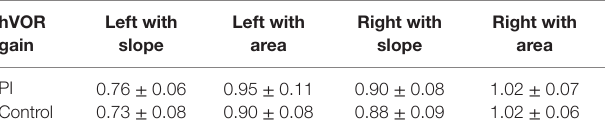
TaBle 2 | Mean hVOr gain calculated with slope and area methods in Pi and control seniors groups. hVOr left with left with right with right with gain slope area slope area PI 0.76 ± 0.06 0.95 ± 0.11 0.90 ± 0.08 1.02 ± 0.07 Control 0.73 ± 0.08 0.90 ± 0.08 0.88 ± 0.09 1.02 ± 0.06 There was no significant difference between the two groups.